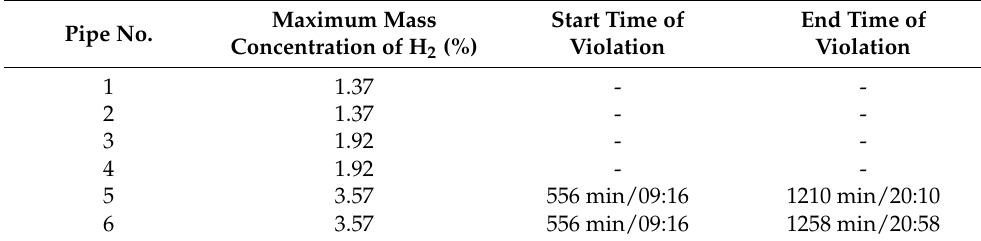
Table 1. The results of hydrogen concentration violation of each pipe in Scenario I. Pipe No.